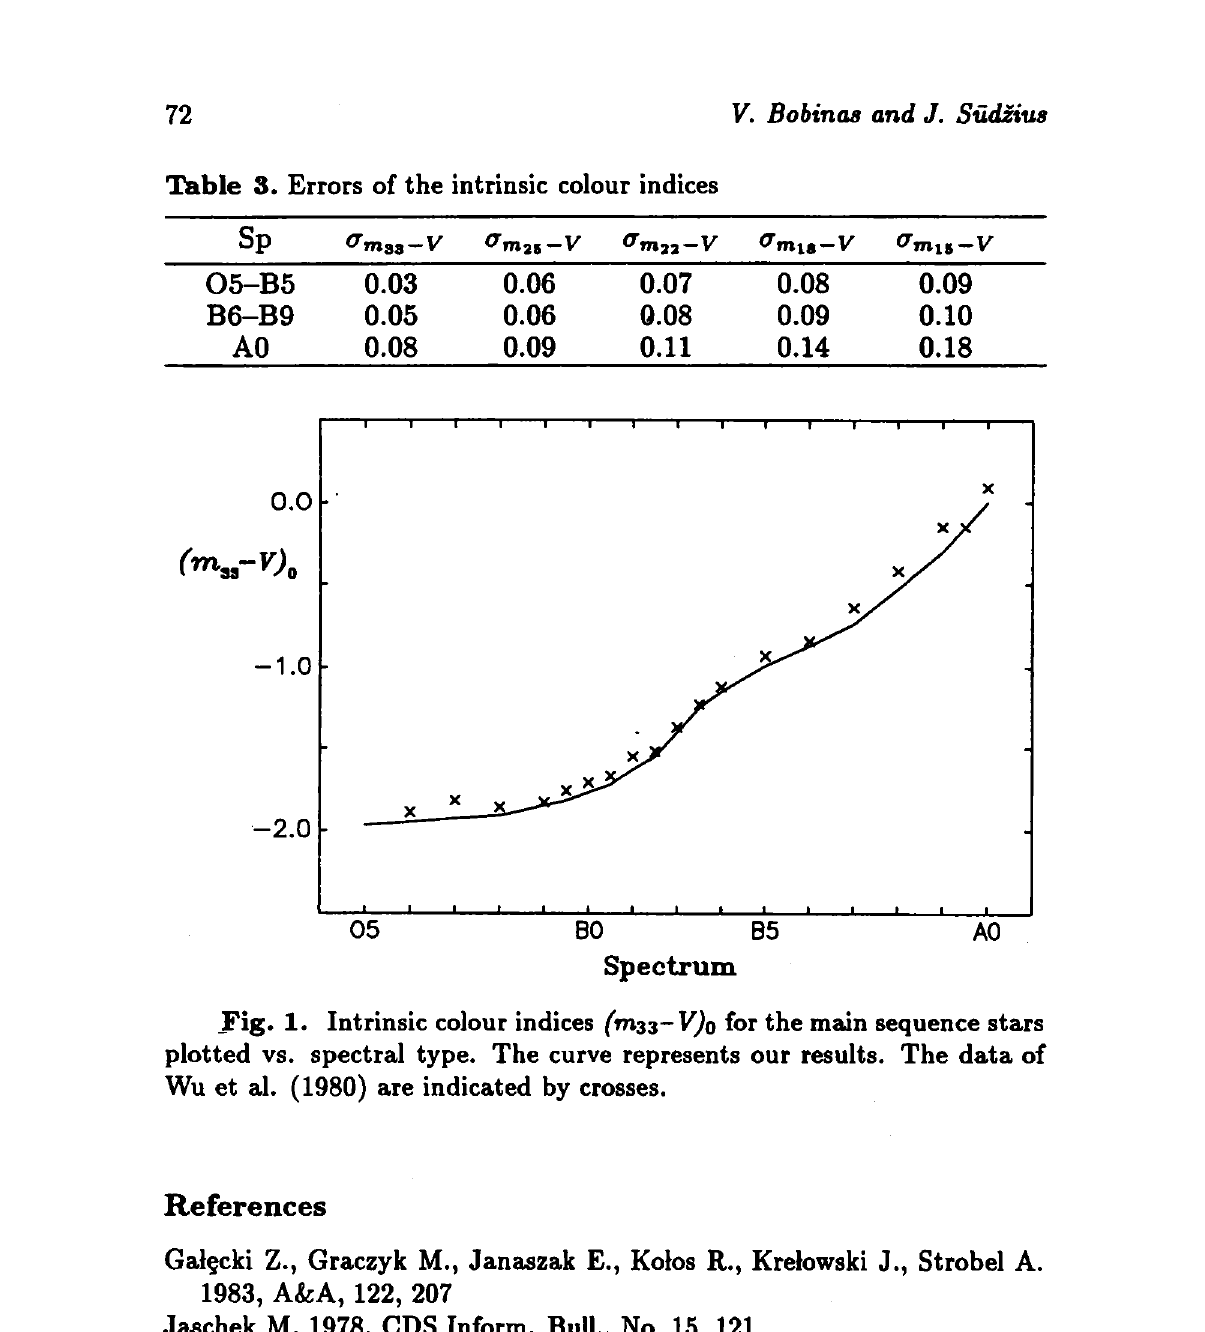
Table 3. Errors of the intrinsic colour indices